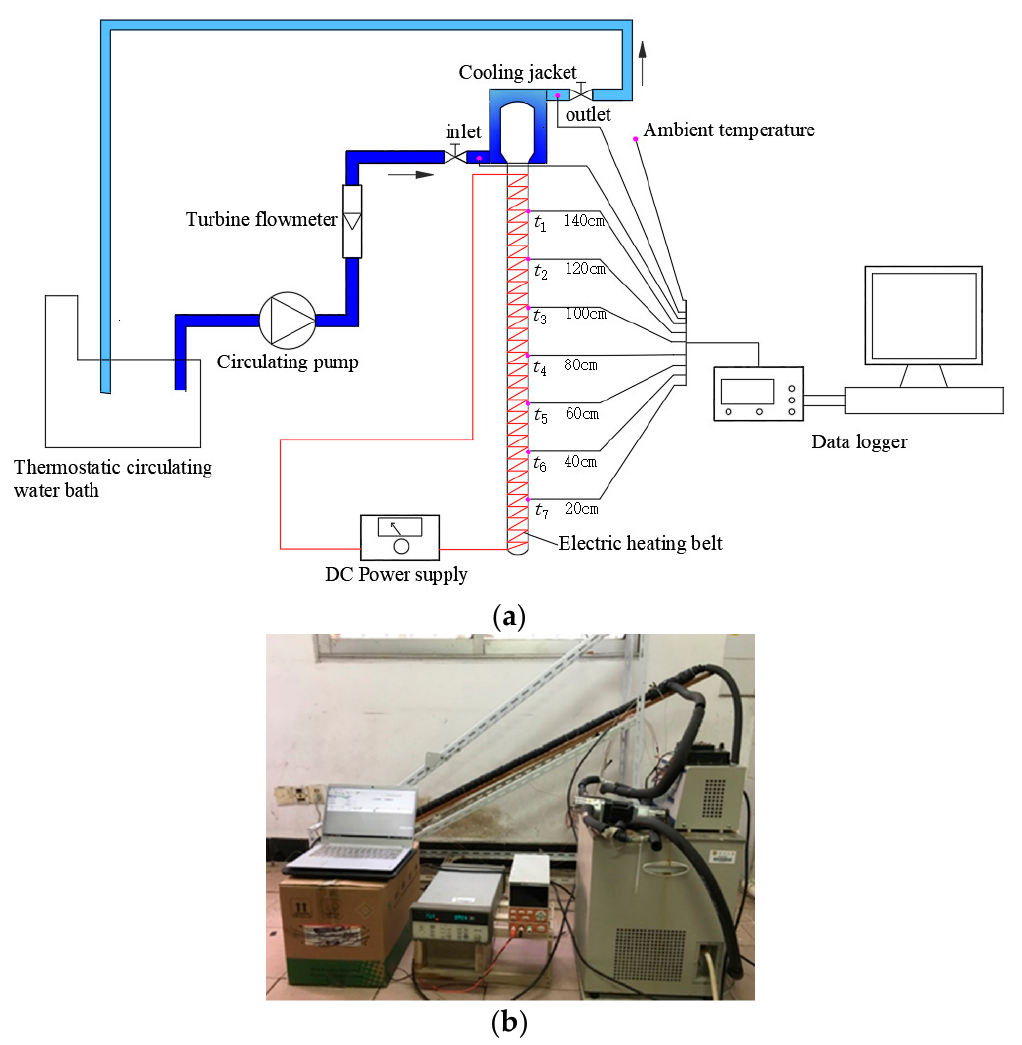
Figure 5. Experimental setup of the start-up characteristics testing for a single solar gravity heat pipe. ( a ) Schematic of the testing system; ( b ) A photograph of the experimental setup.